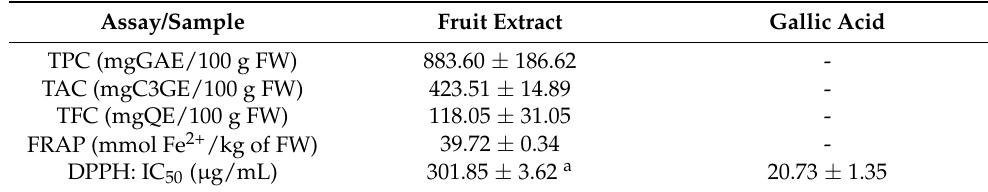
Table 2. TPC, TFC, TFC, and FRAP result from the fruit of U. bojeri and the IC 50 of MEUB on the radical DPPH. Assay/Sample Fruit Extract Gallic Acid